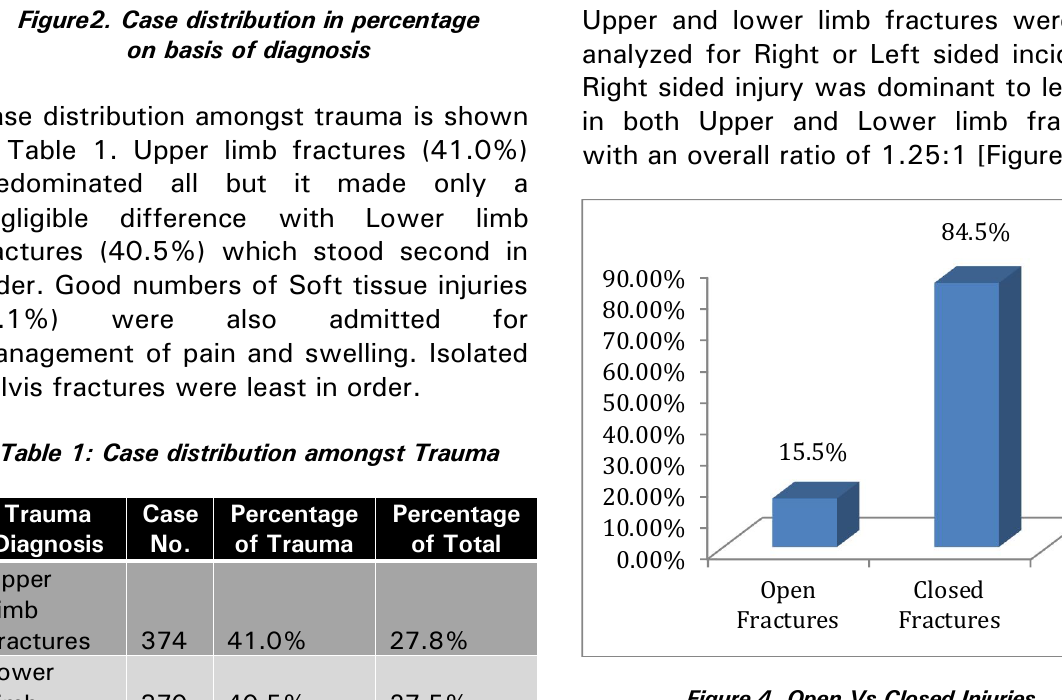
Figure 4. Open Vs Closed